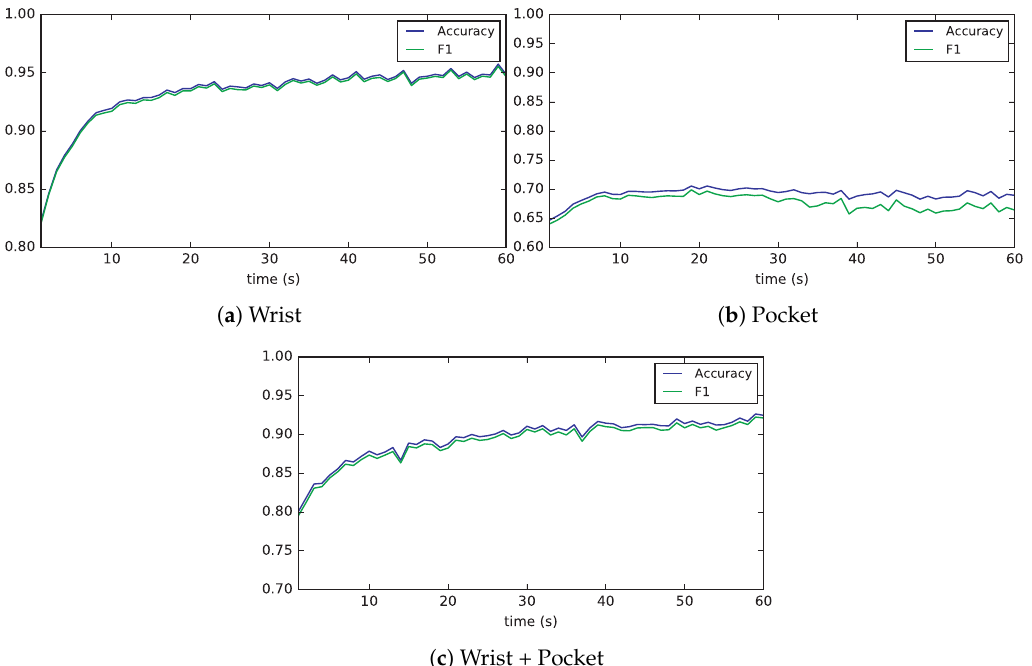
Figure 10. Evolution of accuracy and F1 score as the window size increases for the extremely randomized trees model.